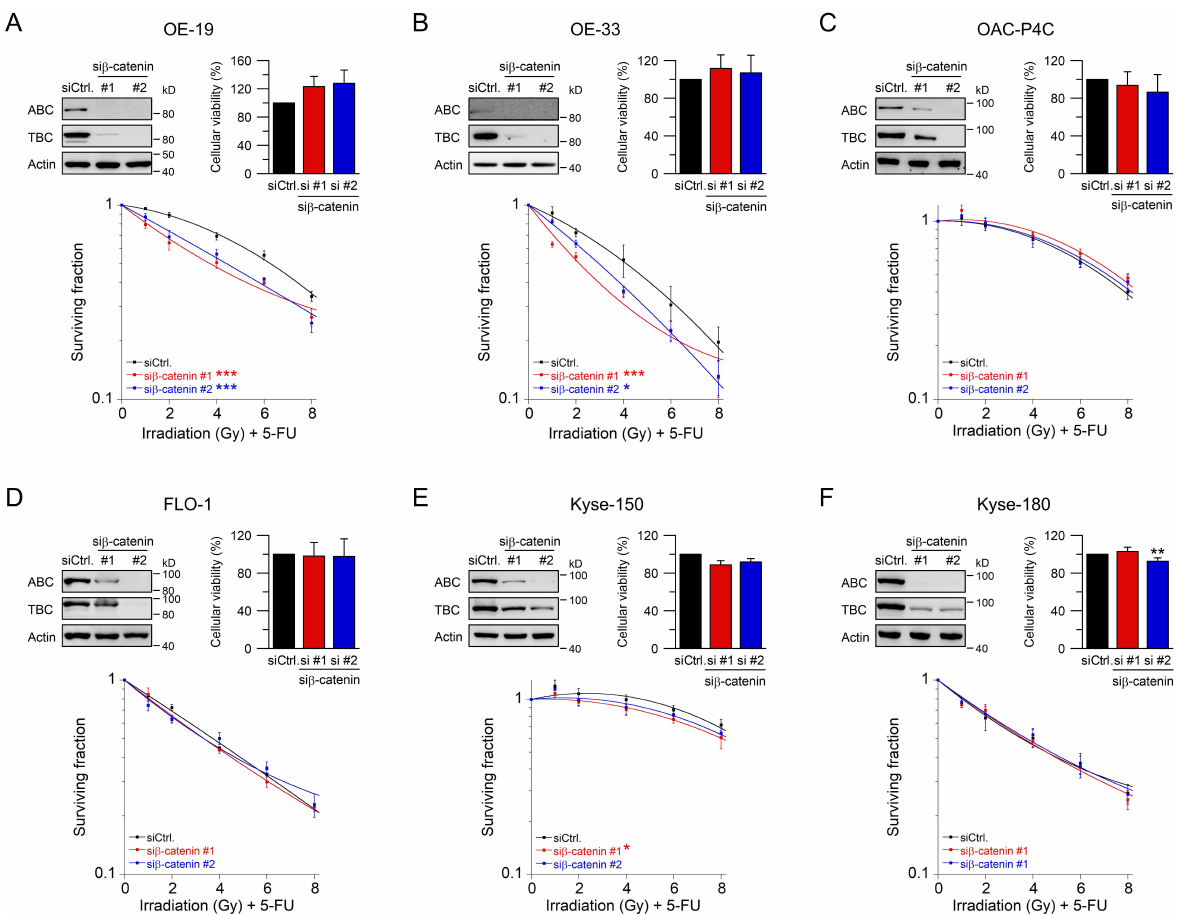
Figure 2. Treatment sensitization following β -catenin depletion depends on the Wnt/ β -catenin-pathway activity. ( A – F ) Signaling-active cell lines OE-19 ( A ) and OE-33 ( B ), and signaling-inactive cell lines OAC-P4C ( C ), FLO-1 ( D ), Kyse-150 ( E ), and Kyse-180 ( F ) were transfected with control siRNA (siCtrl.) or siRNA targeting β -catenin (si β -catenin #1, #2), and subjected to immunoblot analyses (upper left), and cellular viability assays (upper right). Following siRNA-mediated silencing of β -catenin, cells were monitored for CFA survival after irradiation in the presence of 5-FU (CRT) (lower graph). Data presented as mean ± s.e.m. from at least n = 3 independent biological replicates. * p < 0.05, ** p < 0.01, *** p < 0.001, unpaired two-sample Student’s t -test or two-way analysis of variance (ANOVA). For p -values see Table